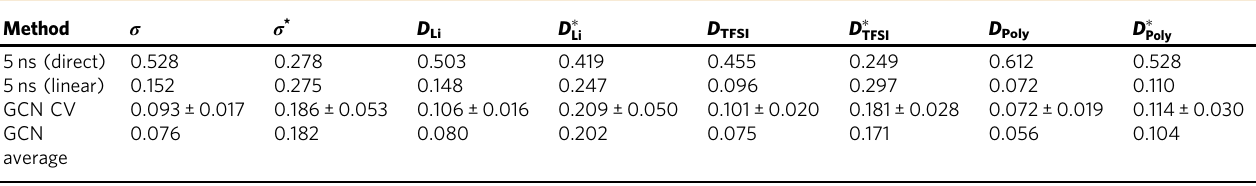
Table 1 Comparison of the mean absolute errors (MAEs) on predicting 50 ns MD simulated properties between different